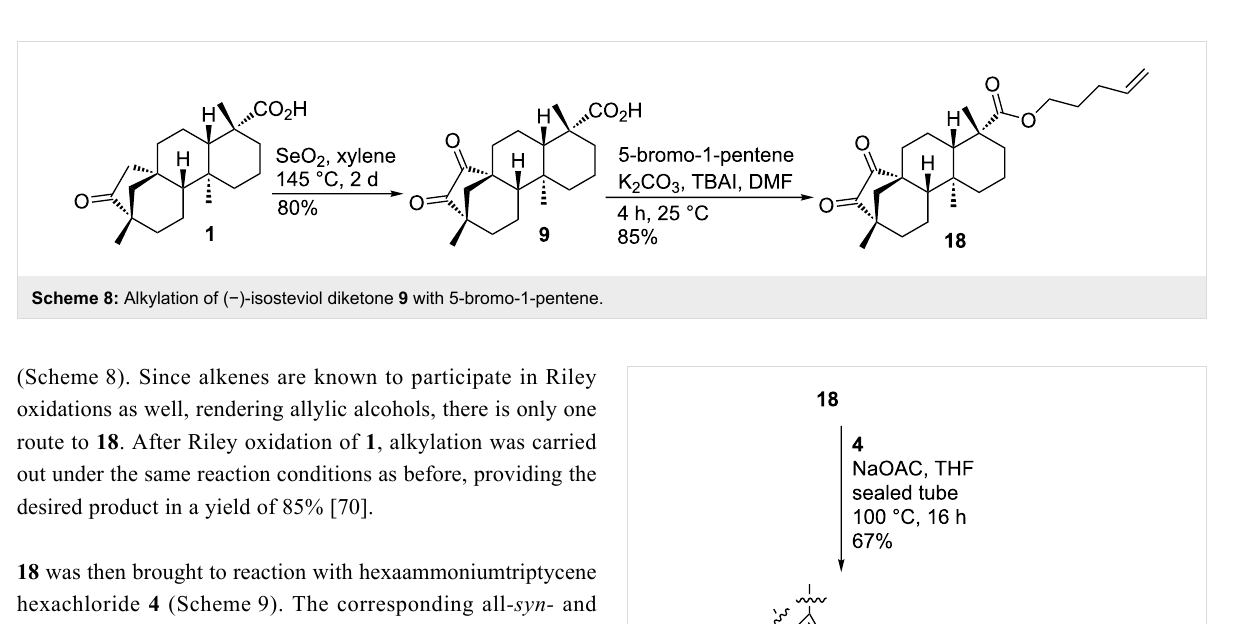
Figure 6: (a) Top view on the molecular structure of all -syn- 17 with the terminal alkene fragments labelled in grey; (b) side view of all -syn- 17 .